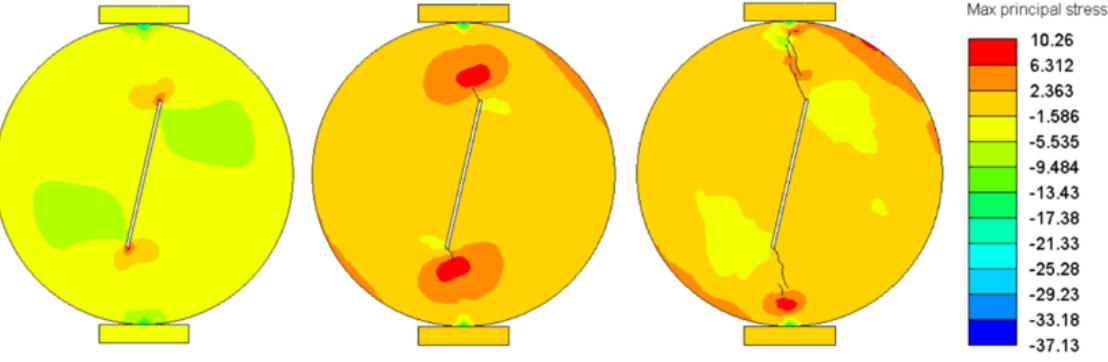
Figure 10. Evolution of maximum principal stress for Brazilian disc with crack of 0° angle.